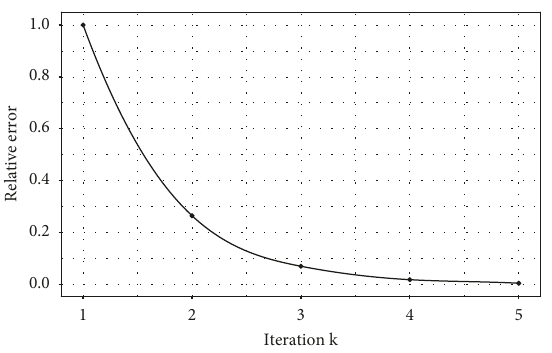
Figure 6: Relative error versus iteration k k � 1 ... 5.